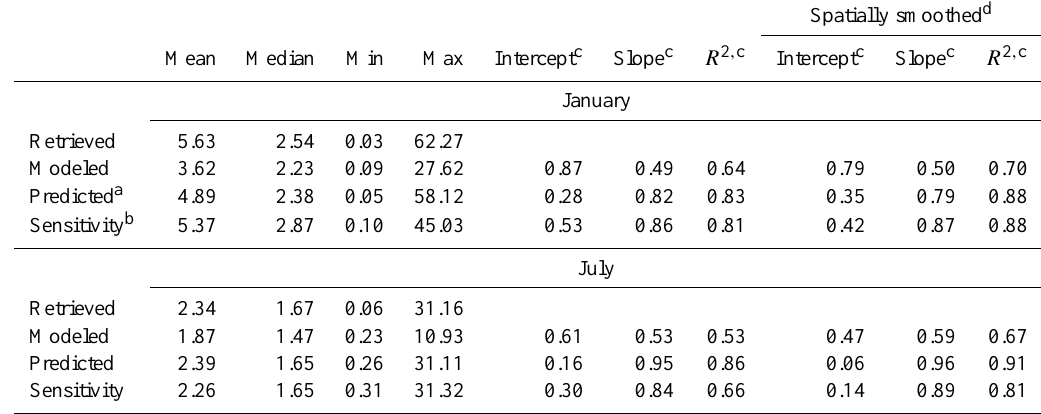
Spatially smoothed d